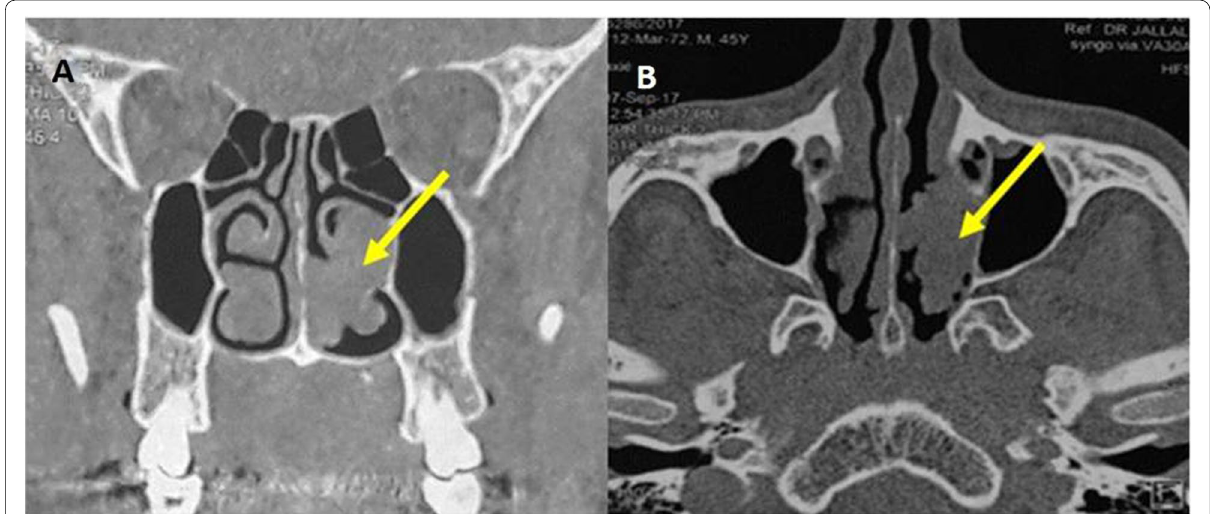
Fig. 1 Sinus CT in coronal ( A ) and axial ( B ) bone window images showing polyploidal mass arising from the left metatal region (arrow) and extending to the homolateral nasal